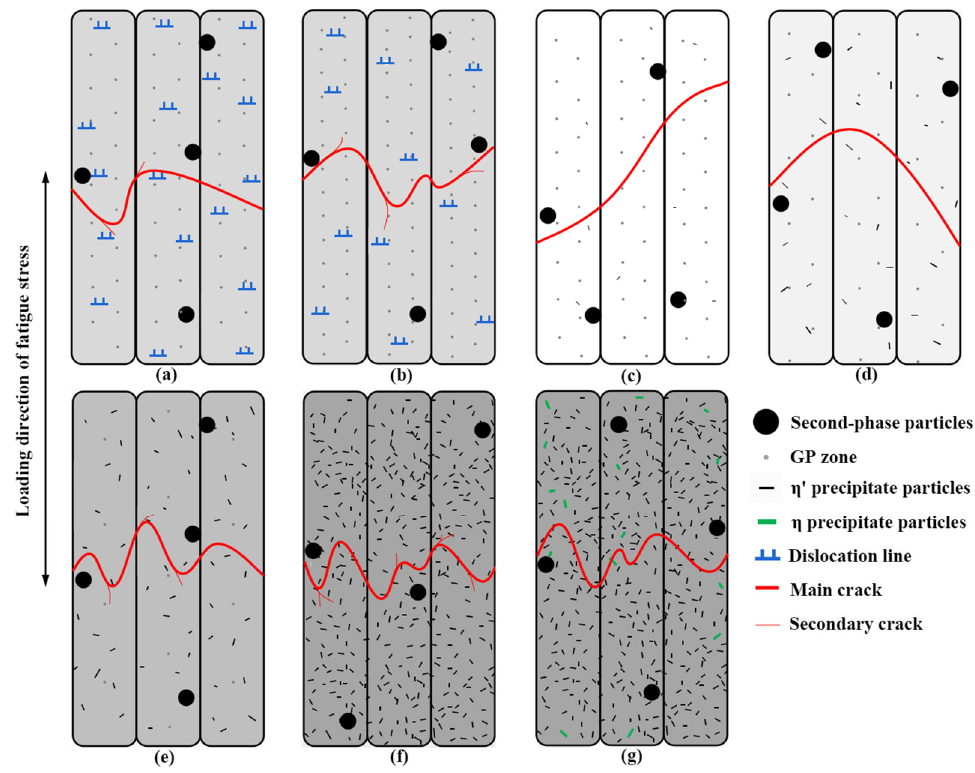
Figure 11. Schematic drawing of fatigue crack initiation and propagation of 7005 aluminum alloy plates with different precipitate configurations: ( a ) small number of GP zones, ( b ) highest volume fraction of GP zones, ( c – e ) GP zones + η (cid:48) , GP zones gradually decrease and η (cid:48) gradually increases, ( f ) all η (cid:48) , and ( g ) large amount of η (cid:48) + small amount of η . Note: The matrix color represents the degree of matrix strengthening, with a darker color indicating higher matrix